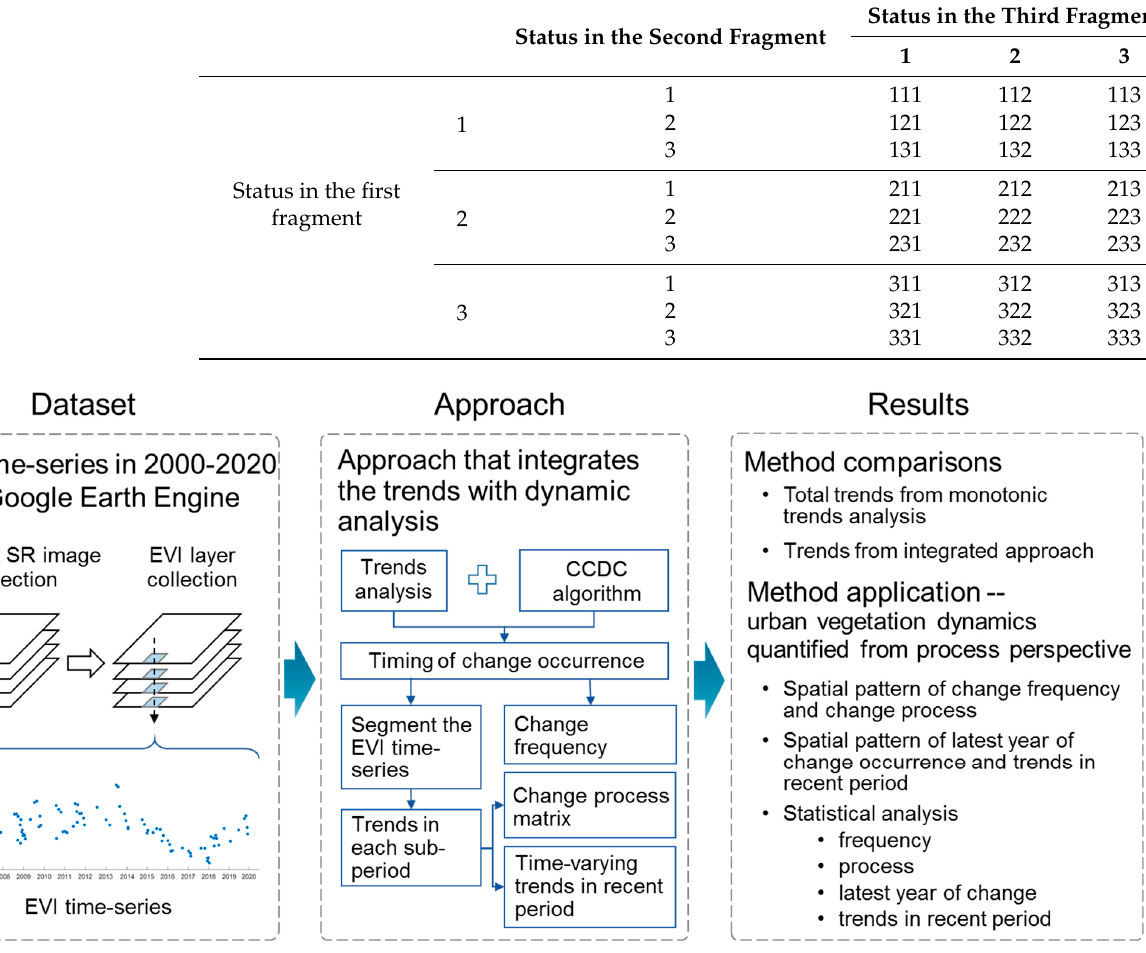
Figure 2. Overview of the approach integrating the trends with dynamic analysis and characterization of the urban vegetation from the process perspective.